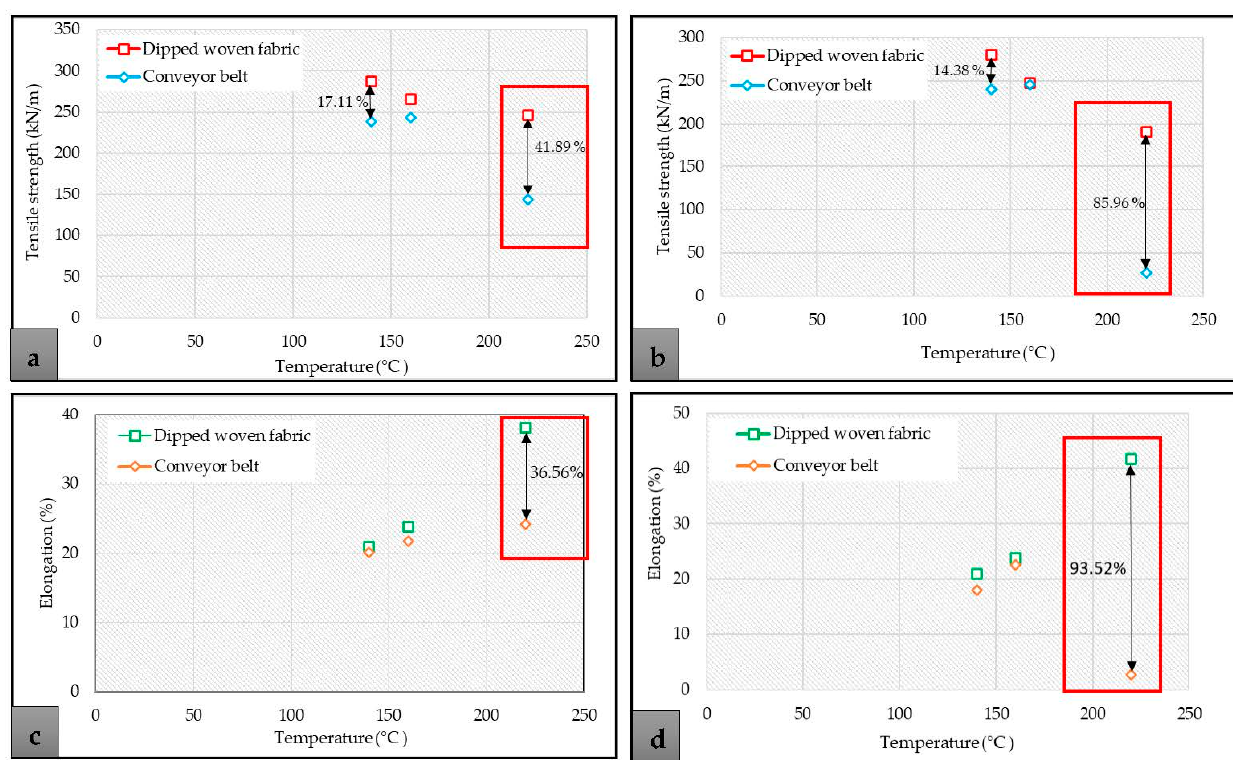
Figure 13. Comparison of tensile strength of thermally aged woven fabric with single ply of the conveyor belt’s carcass. ( a ) Tensile strength of dipped woven fabric and conveyor belt that underwent thermal aging for 6 min; ( b ) Tensile strength of dipped woven fabric and conveyor belt that underwent thermal aging for 35 min; ( c ) Percentage elongation of dipped woven fabric and conveyor belt that underwent thermal aging for 6 min; ( d ) Percentage elongation of dipped woven fabric and conveyor belt that underwent thermal aging for 35 min.